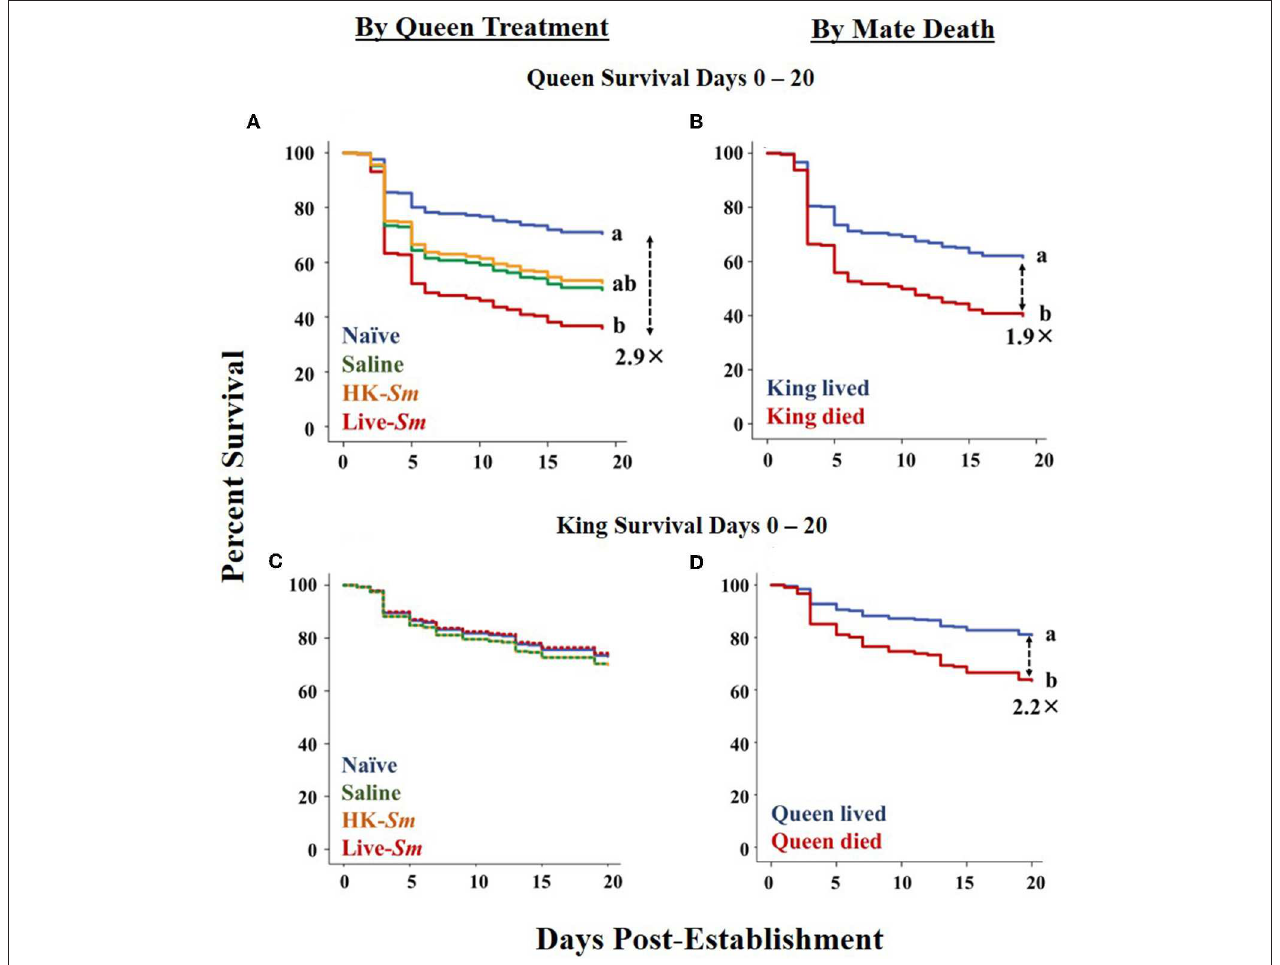
FIGURE 2 | Survival curves across the first 20 days post-establishment (Cox model). (A) Queen survival as a function of queen treatment. (B) Queen survival as a function of king death. (C) King survival as a function of queen treatment. The survival curves for kings mated to saline queens overlaps with those mated to HK- Sm queens. Similarly, there is overlap between the curves of kings mated to saline and live- Sm queens. (D) King survival as a function of the death of his queen. Dashed arrows with corresponding numbers indicate hazard ratios of death between the significant pairwise